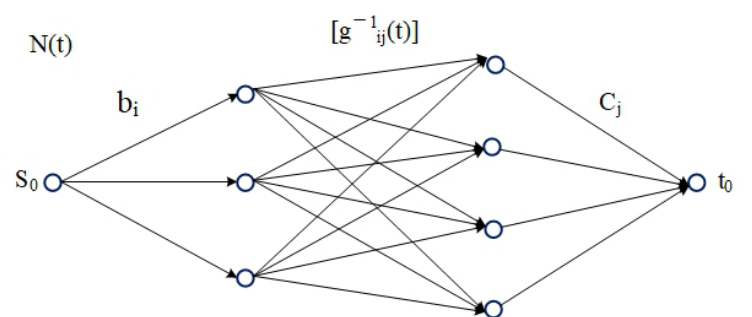
Figure 2. Network flow diagram N ( t )